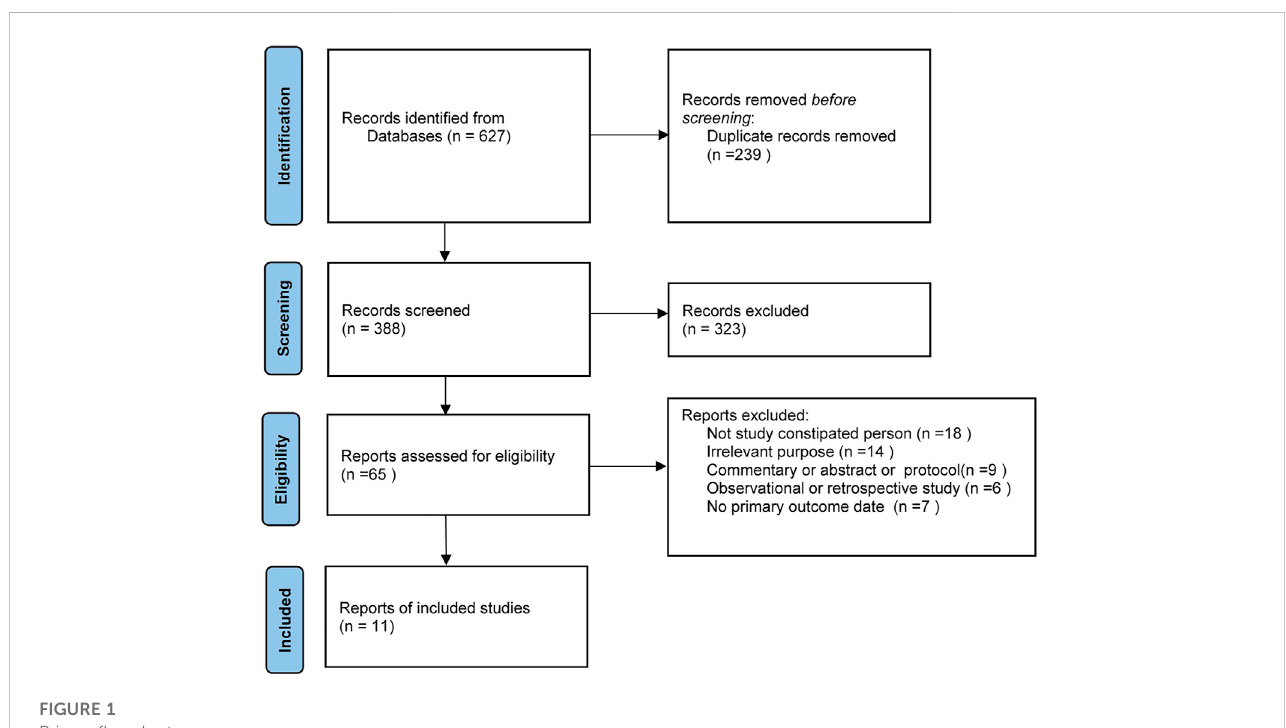
FIGURE 1 Prisma fl